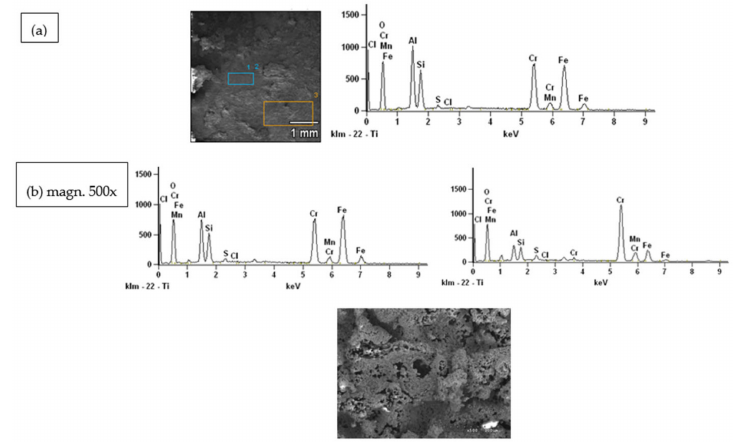
Figure 18. ( a ) Chemical composition of the surface of heat-resistant steel H24JS in planes pt1, pt2 and pt3; ( b ) microscopic photo (SEM) of the surface of H24JS heat-resistant steel.